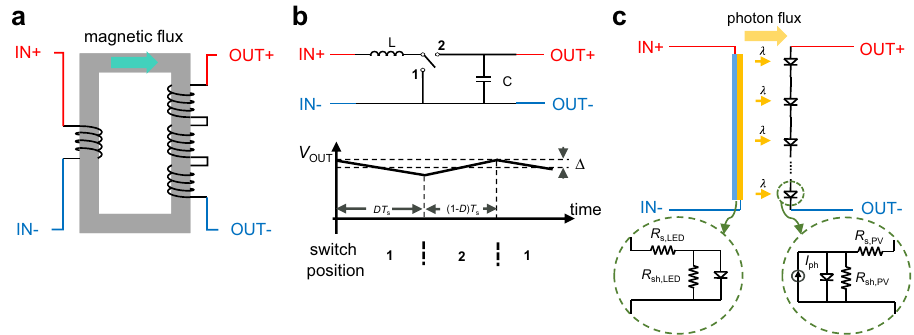
Fig. 1 Schematic of an AC transformer, a step-up switching DC converter, and our proposed DC photonic transformer. a Schematic of a conventional transformer. Input (AC) voltage on the primary winding generates an alternating magnetic fl ux in the magnetic core (gray rectangular ring), which induces a scaled version of the voltage on the secondary winding. The voltage-conversion ratio is determined by the winding ratio between the two coils. b Schematic of a typical switching step-up (boost) converter circuit and its steady-state output voltage as a function of time under linear-ripple approximation 1 . The circuit operates by temporally alternating the switch position between 1 and 2 resulting in the charging and discharging of the energy storage elements. D duty cycle, T s switching period, Δ output voltage ripple magnitude. c Schematic of the proposed DC photonic transformer. The photon fl ux emitted by the LED and received by the PV cell acts as a current source for the external load of the PV cell. The inset shows the series resistance and the shunt resistance of the PV cell and